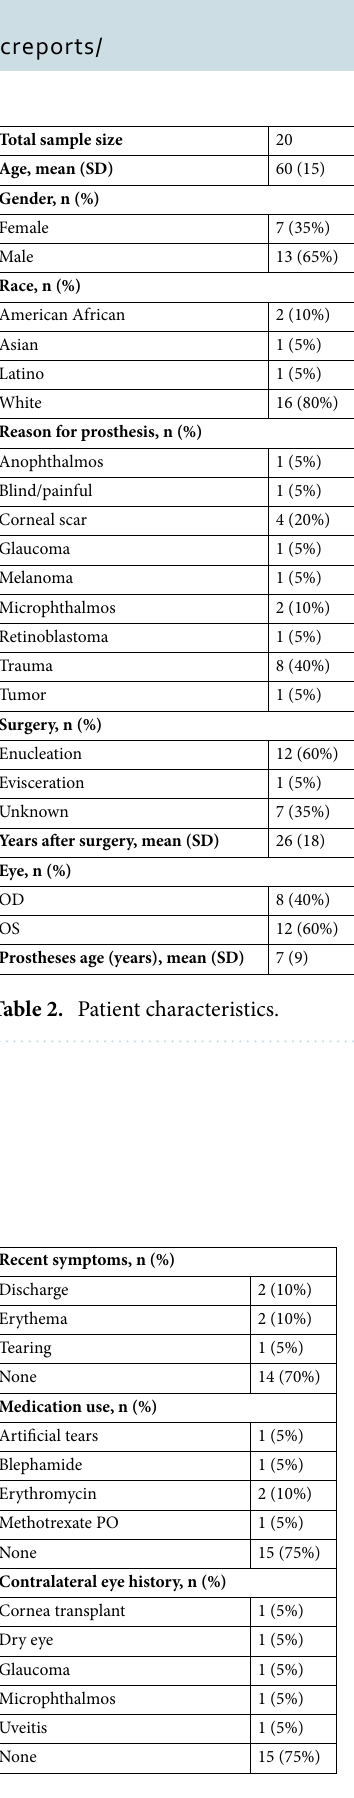
Table 3. Clinical